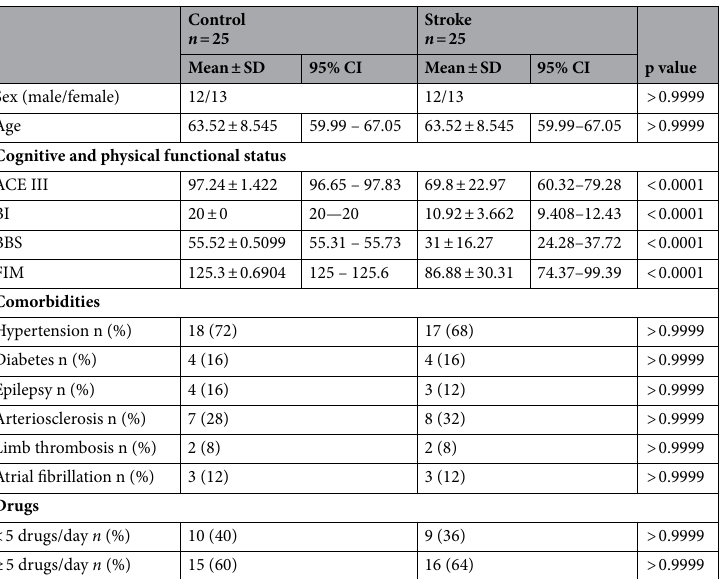
Table 1. General characteristics of patients. ACE III Addenbrooke’s Cognitive Examination, BI Barthel Index, BBS Berg Balance Scale, FIM functional independence measure; differences statistically significant at: *p < 0.05;